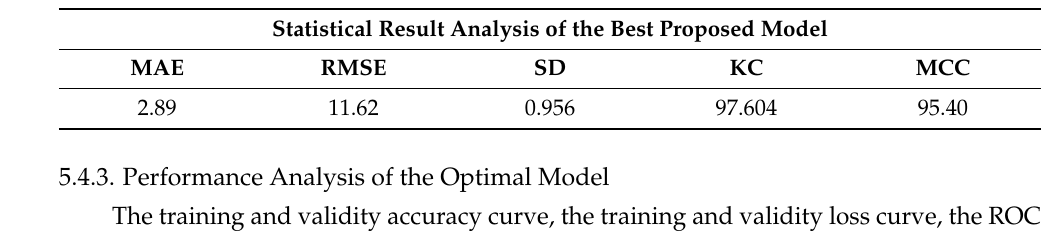
Table 7. Statistical result analysis of the optimal configuration of the proposed